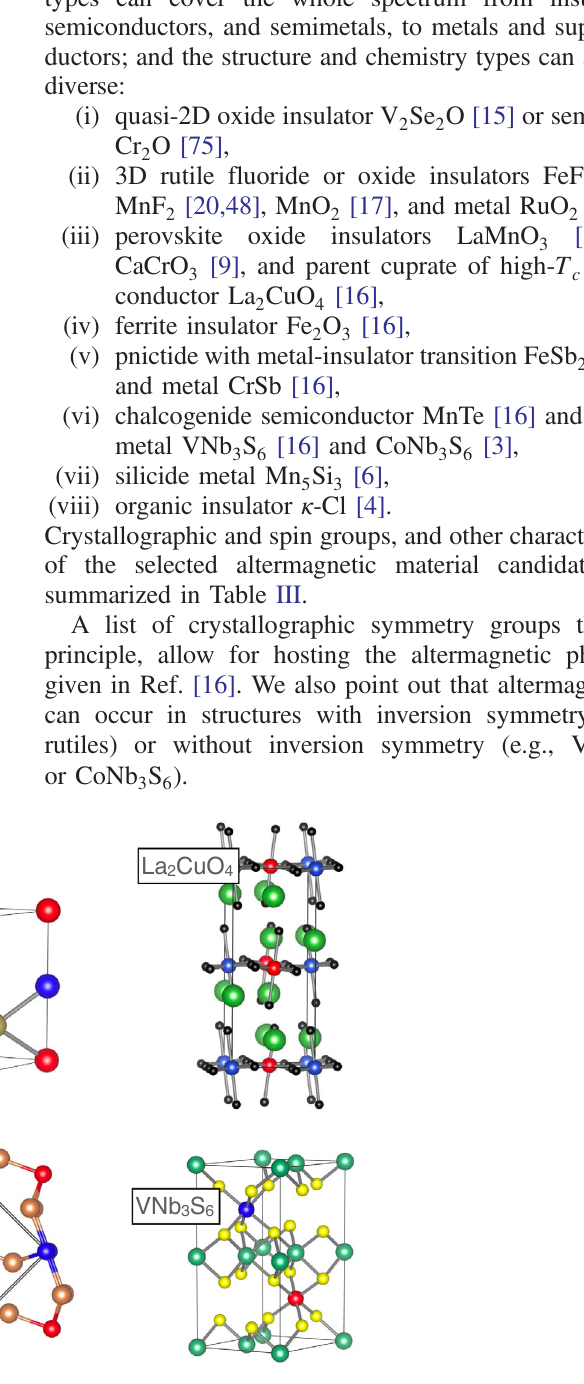
FIG. 6. Crystal structures of selected altermagnetic candidates organized by dimensionality and conduction type. The crystal structure are discussed in detail in Refs.